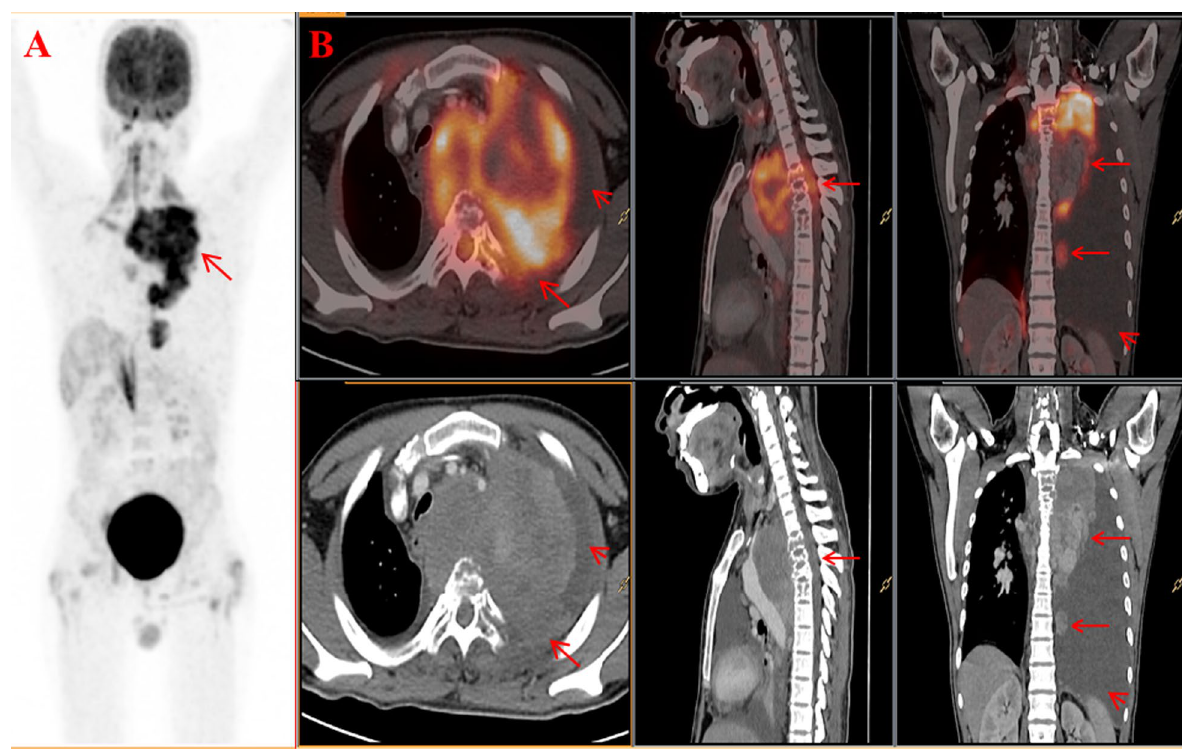
Fig. 1 A 20-year-old male, presented with pain in mid-back for one month, weakness of sudden onset in bilateral lower limbs for 1 week which progressed to a complete loss of function of both legs, incomplete voiding of urine and constipation for the past 2 days. Maximum intensity projection (MIP) image of 18F FDG PET scan A showing a large area of tracer uptake in the left hemithorax and midline region. Axial, sagittal and coronal PET/CT and corresponding CT images B showing metabolically active large posterior mediastinal mass with intracanalicular extension (in sagittal images) and left mediastinal pleural deposits (in coronal images) with left pleural effusion (arrow